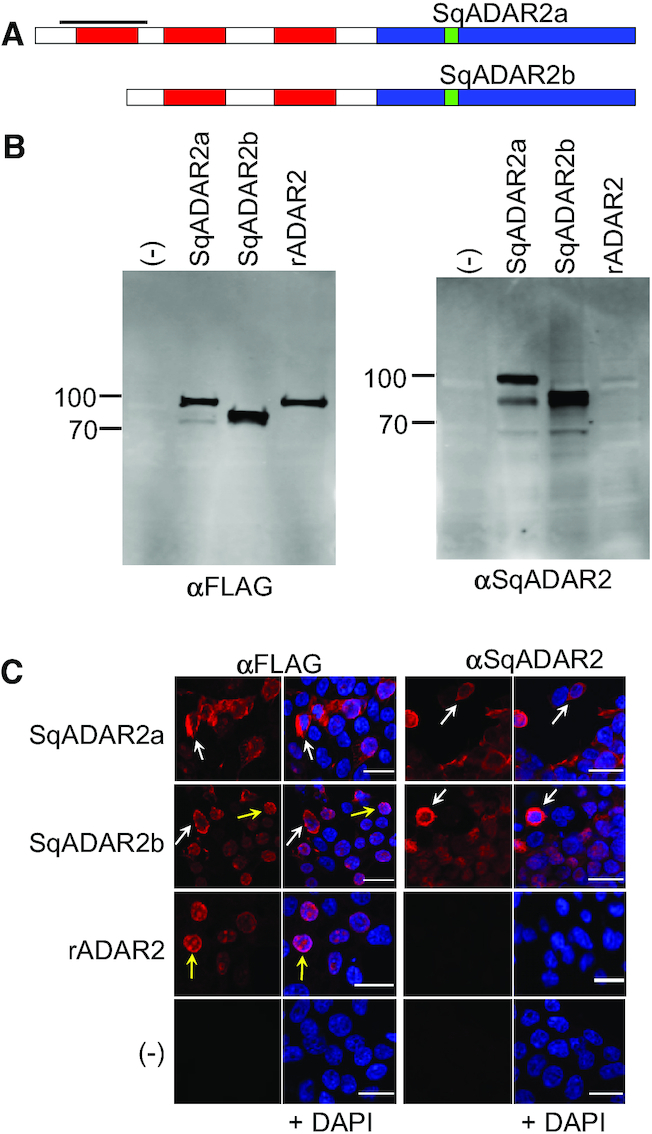
sqADAR2 enzyme is expressed in the cytoplasm in transiently transfected HEK-293T cells. (A) Schematic of the two ADAR2 isoforms expressed in squid (sqADAR2a and sqADAR2b). Deaminase domain is shown in blue, dsRBMs are shown in red and the epitope used for antisera development is shown in green. Bold line indicates the extra dsRBM found exclusively in sqADAR2a. (B) Western blot analysis of expression of sqADAR2a, sqADAR2b, rADAR2 and pcDNA3.1(−) empty vector after transient transfection in HEK-293T cells using either α-FLAG or α-sqADAR2. Membranes were imaged using a LI-COR odyssey infrared imaging system. Full-length sqADAR2a is 89 kDa, sqADAR2b is 71 kDa and rADAR2 is 83 kDa. No signal was detected in cells transfected with pcDNA3.1 empty vector; n = 2. (C) Immunostaining of full-length recombinant proteins after transient transfection in HEK-293T cells. Images are 100× and scale bars = 19 μm. Yellow arrows point to clear examples of cytoplasmic expression of both sqADAR2a and sqADAR2b enzymes. Cells were visualized using a Nikon A1R imaging system; n = 2.